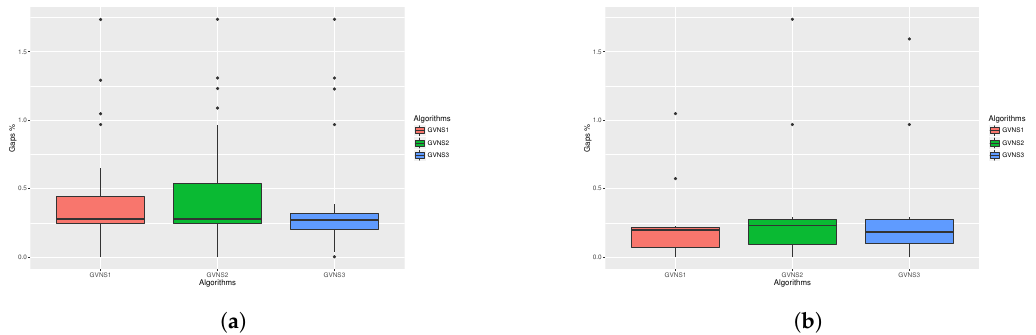
Figure 5. Statistical test for nTSP (1/2). ( a ) Statistical test box plots for nTSP 1min FI; ( b ) Statistical test box plots for nTSP 1min BI.